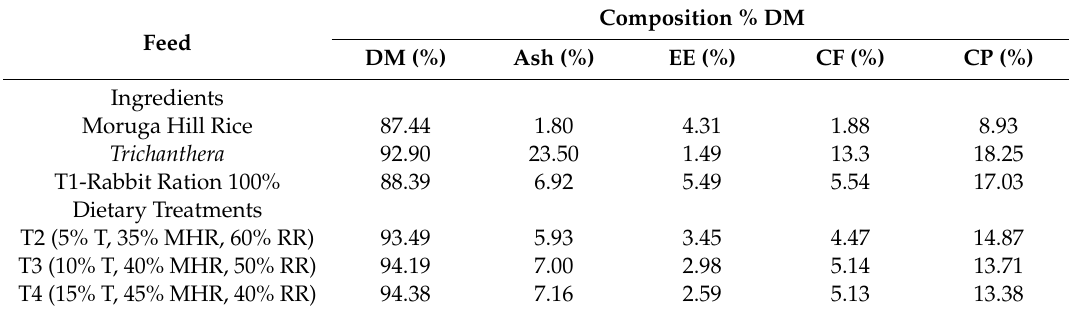
Table 1. Proximate analysis of the feed ingredients and diet treatments